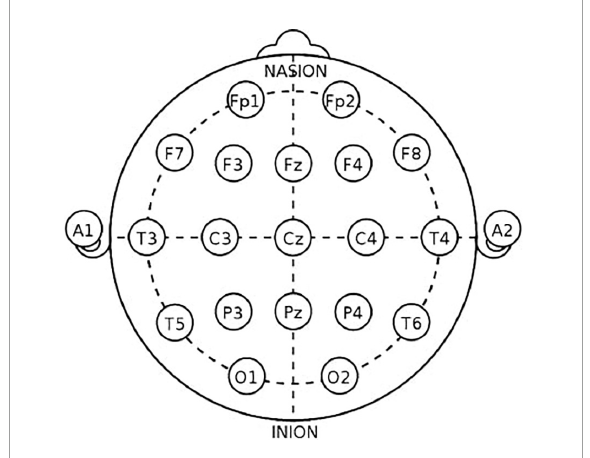
FIGURE1 Montage of the international 10–20